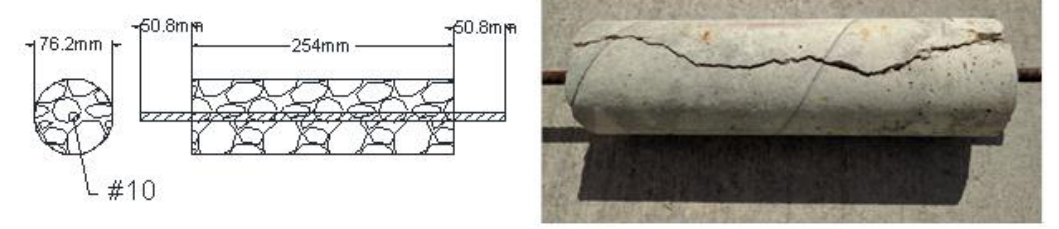
Figure 2. Cylindrical specimens with a single rebar for corrosion and cracking studies.